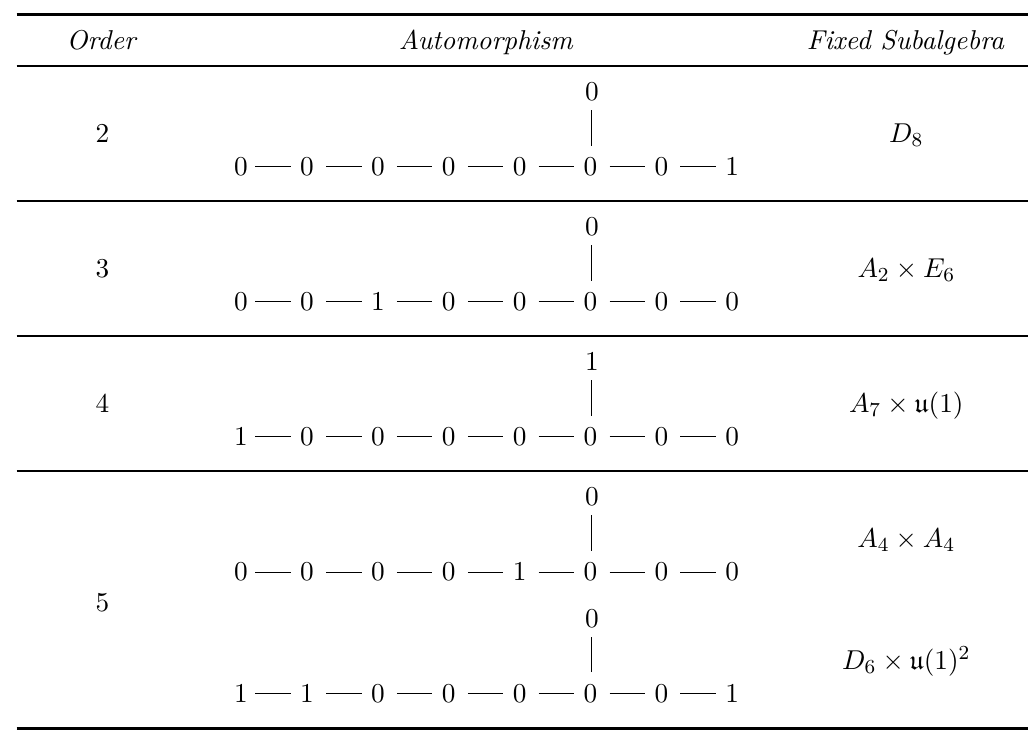
Table 3 . List of non-anomalous symmetries of the E 8 Lie algebra and fixed point Lie subalgebras up to order m = 5 . Instead of listing the corresponding sequence s for the automorphism, we mark s onto the (affine) E 8 Dynkin diagram, illustrating the origin of the fixed Lie